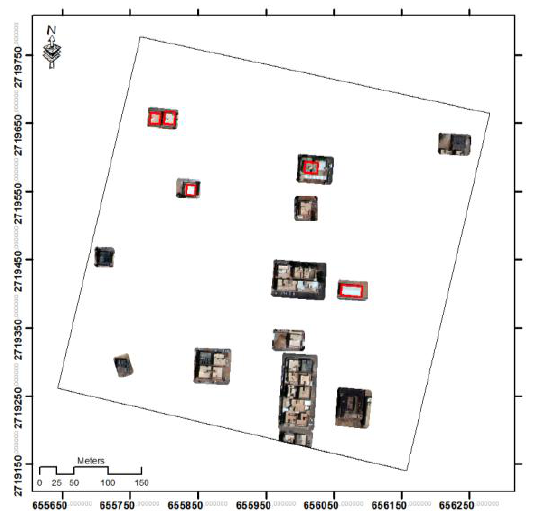
Figure 10. Outline delineation for new buildings using 3D edge